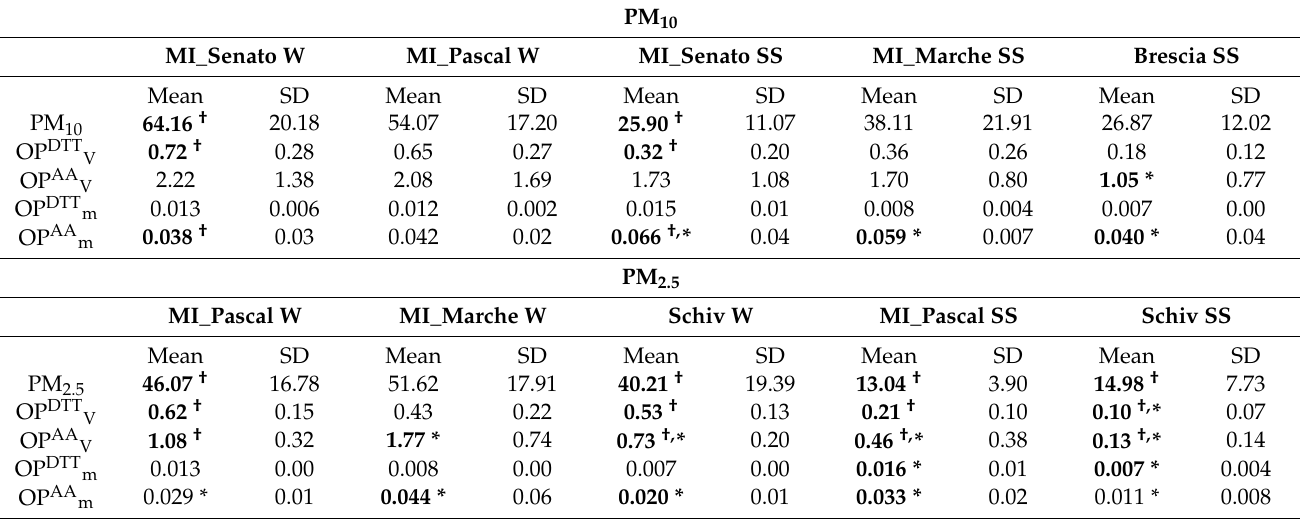
Table 2. PM 10 and PM 2.5 mass concentration and OP responses measured at the five sites during the various sampling campaigns: means and standard deviation of each campaign data.